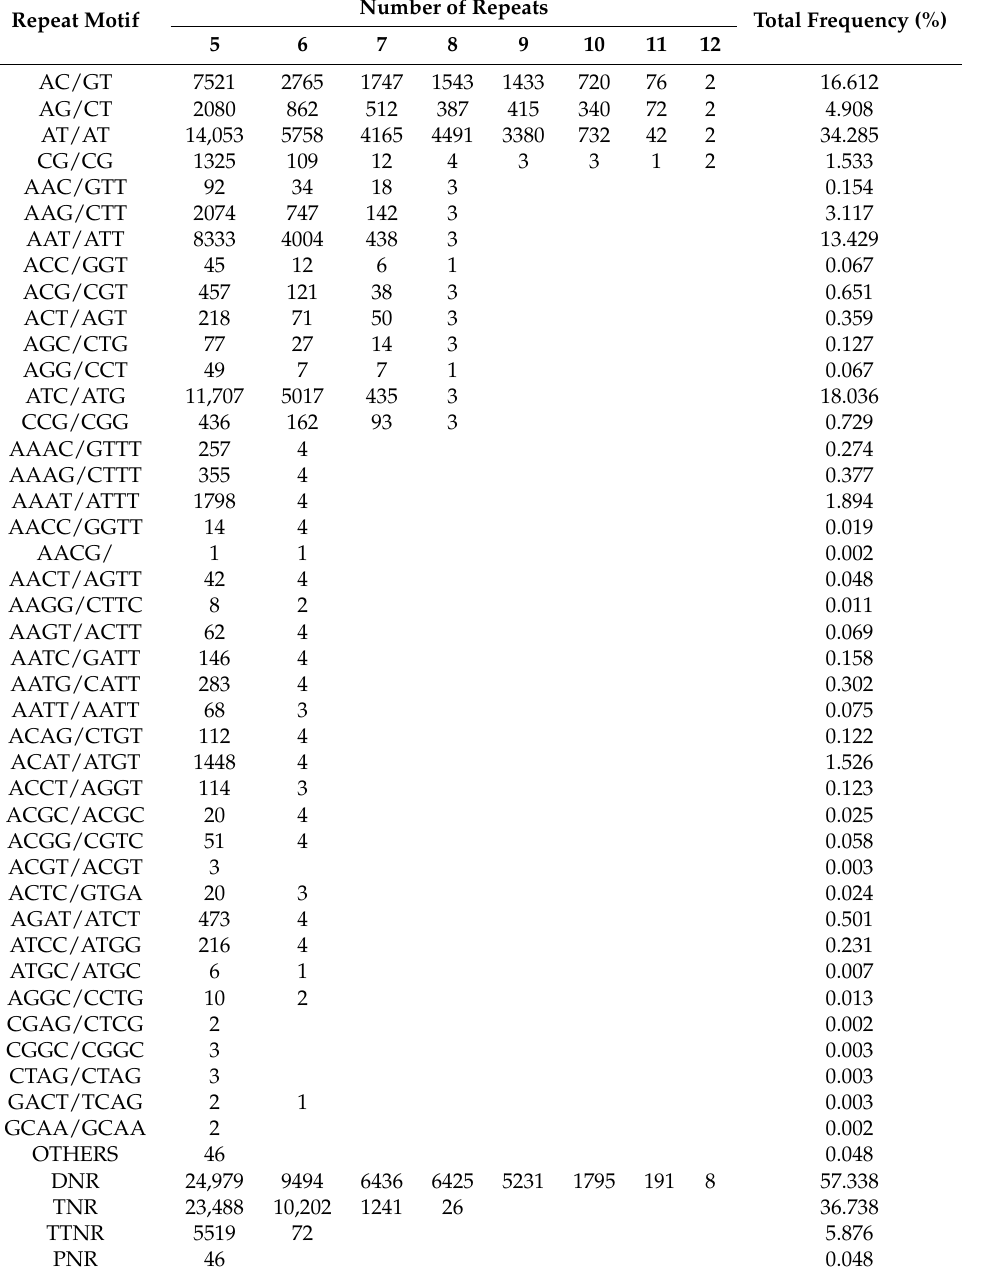
Table 1. Distribution of microsatellites with different motifs and repeat numbers in Carposina